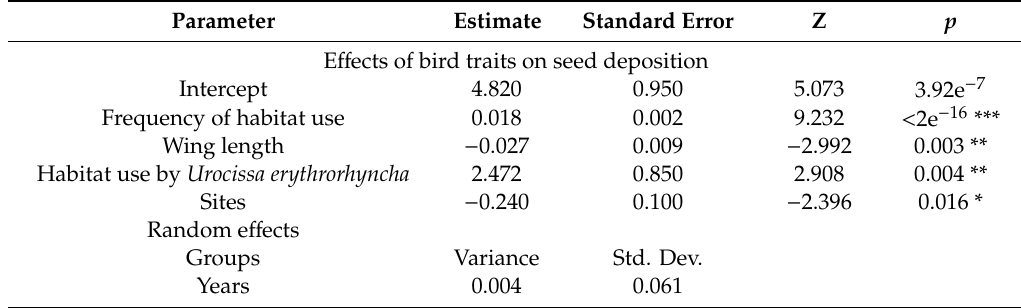
Table 2. Analyzing the e ff ects of bird traits on the seed deposition and seedling recruitment of the endangered Taxus chinensis (Pilger) Rehd across in-situ and ex-situ sites (generalized linear mixed-e ff ects models with a Poisson